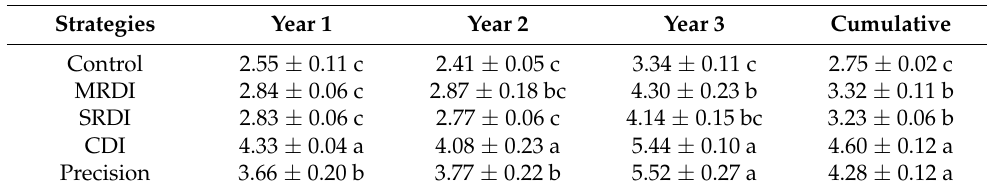
Table 10. Water productivity was measured as olive oil weight per irrigation volume for different irrigation strategies during the three test years and cumulative value. Values were mean ± standard deviation. Different letters showed significant differences ( p ≤ 0.05) among treatments according to Duncan’s